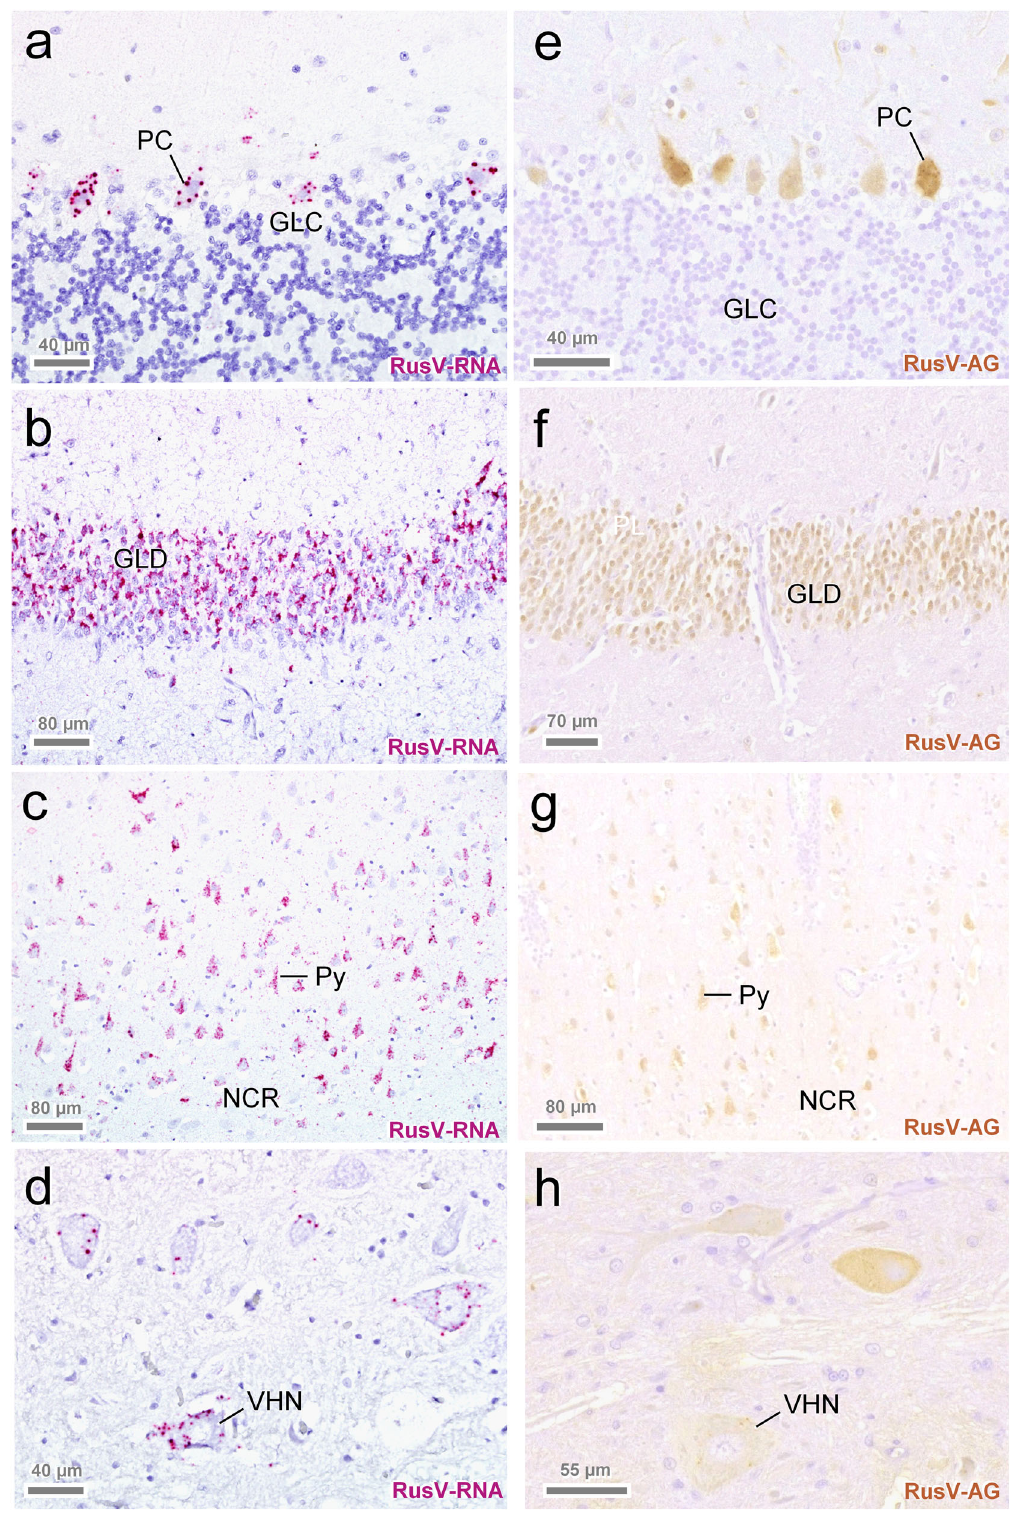
Fig. 3 | Detection of rustrela virus (RusV) RNA and antigen in the central ner- vous system of encephalitic cats. RusV RNA was detect by RNAscope in situ hybridization ( a – d ), while RusV capsid protein was detected by immunohis- tochemistry ( e – h ). Detection of rustrela virus (RusV) RNA by RNAscope in situ hybridization ( a – d ) and RusV antigen by immunohistochemistry ( e – h ) in the central nervous system of encephalitic cats. Both virus RNA and capsid protein were located mainly in the cytoplasm of different nerve cell populations. Typical are spherical reaction products, which may coalesce to more extensive and/or diffuse signal. Neurons with the highest viral load were particularly Purkinje cells